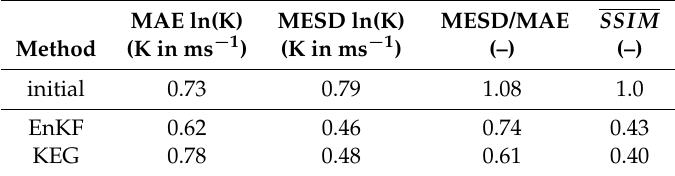
Table 4. Mean absolute error (MAE) of the ensemble-averaged log-K field, mean ensemble standard deviation of log-K (MESD), MESD/MAE ratio, and ensemble-averaged structural similarity index (SSIM) estimated after the assimilation the tracer data from tracer tests A and B. EnKF: ensemble Kalman filter. KEG: Kalman ensemble generator. MAE ln(K) MESD ln(K) MESD/MAE SSIM Method (K in ms − 1 ) (K in ms − 1 )